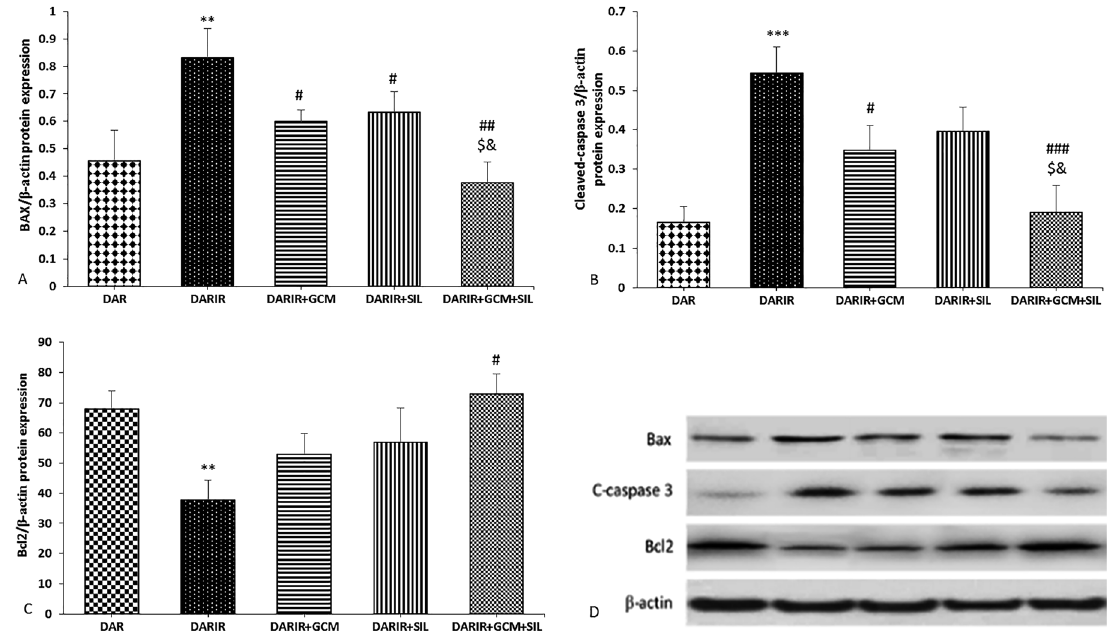
Figure 3: Pro- and anti-apoptotic proteins expression in liver tissue. (A) Bax; (B) cleaved caspase 3; (C) Bcl2; and (D) representative immu- noblots. The data was expressed as mean ± SD. N=6 for each group. **p<0.01 and ***p<0.001 as compared with DAR group; #p<0.05, ##p<0.01, and ###p<0.001 as compared with DARIR group. $ p<0.05 and & p<0.05 as compared with DARIR + GCM and DARIR + SIL groups, respectively. DAR, diabetic aged rat; DARIR, diabetic aged rat subjected to ischemia-reperfusion; GCM, ginsenoside compound-Mc1; SIL,